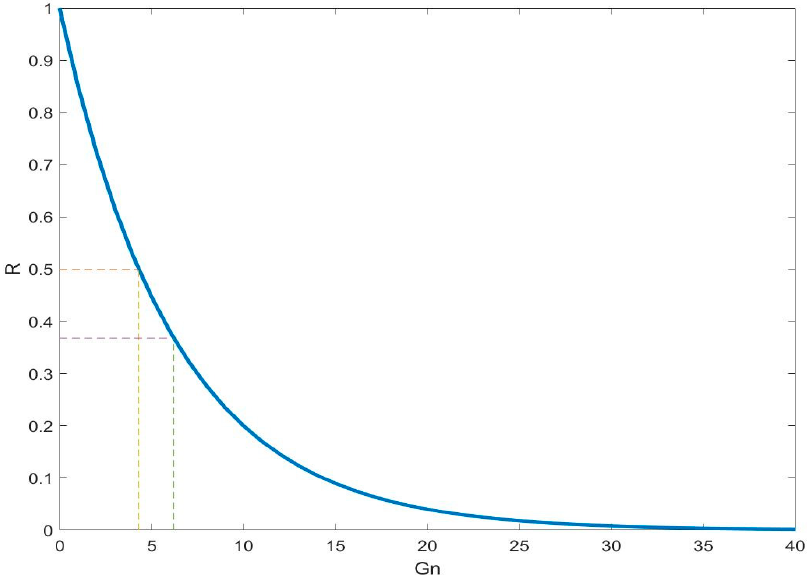
Figure 5. Reliability curve of exponential distribution.